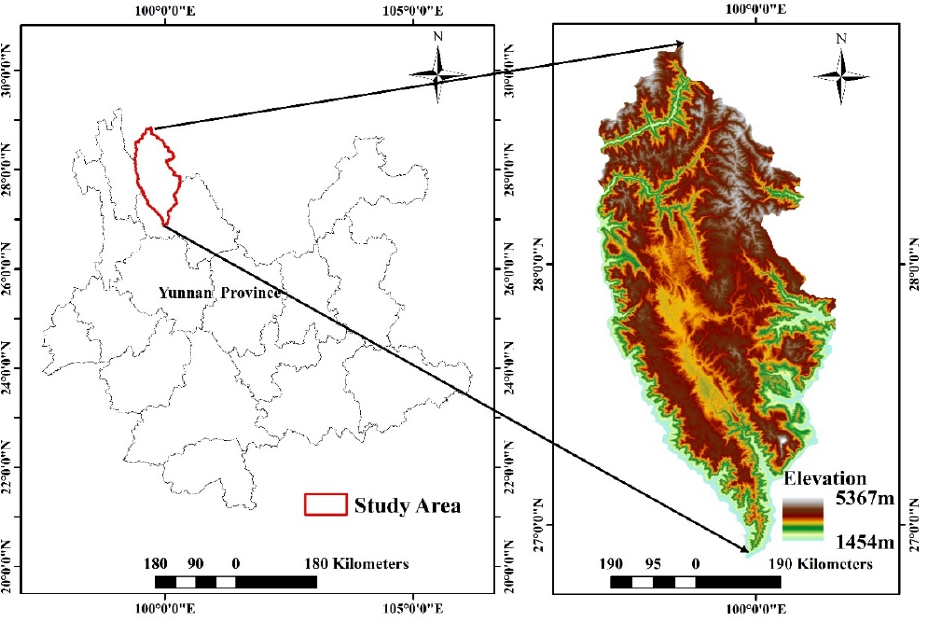
Figure 1. Location of the Shangri-La study area in